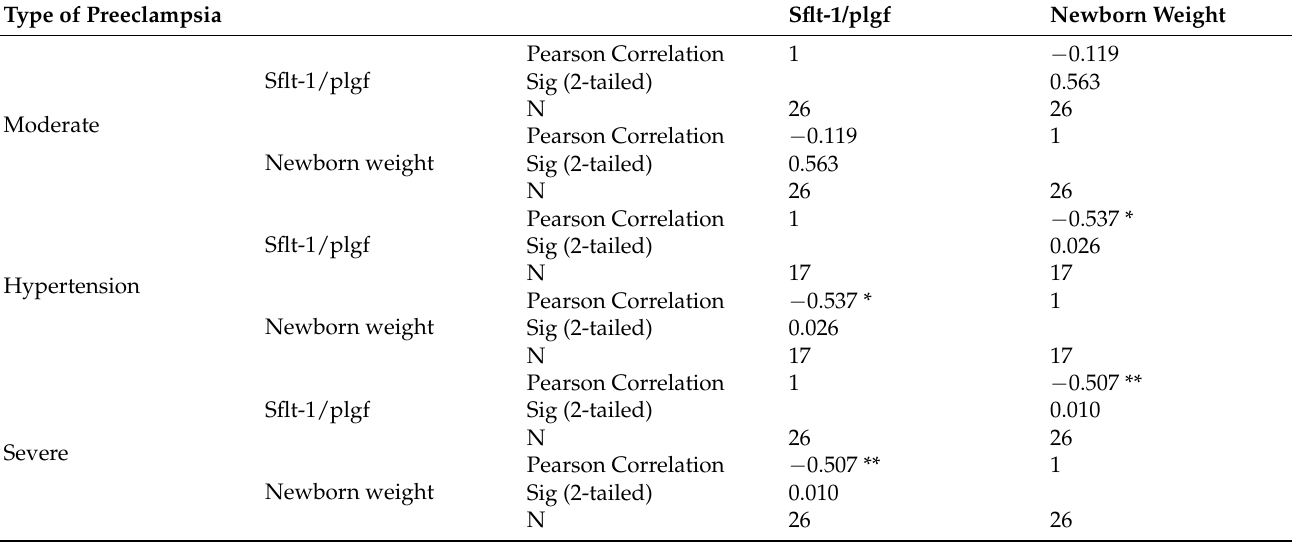
Table 5. Correlation between newborn weight and values of sFlt-1/PlGF.